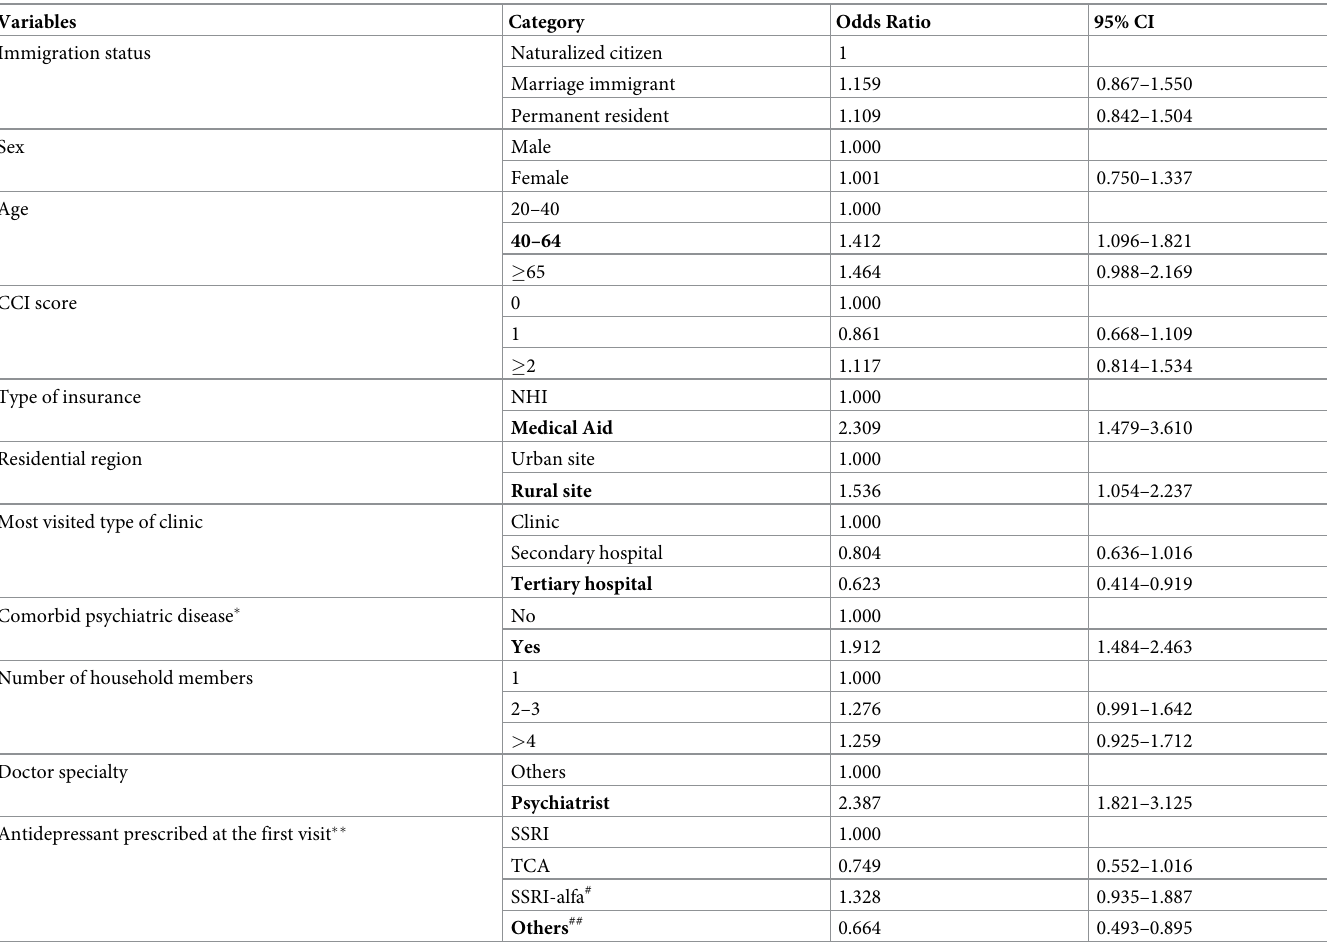
Table 4. Factors affecting appropriateness of care (AOC) in depression management among immigrants by multivariate logistic